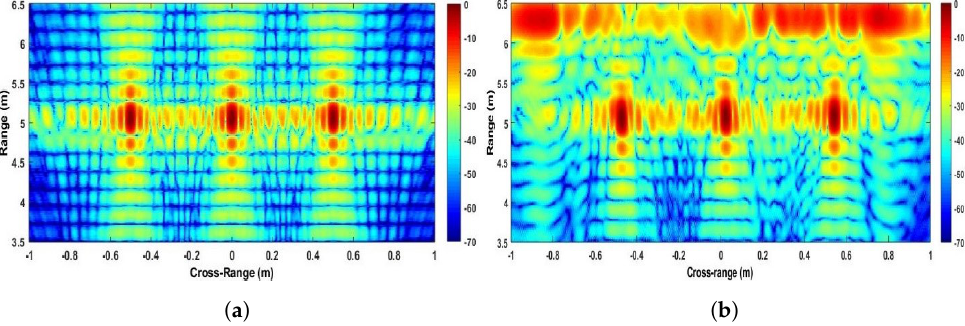
Figure 11. Image of Stripmap SAR for ( a ) simulation and ( b ) experiment.